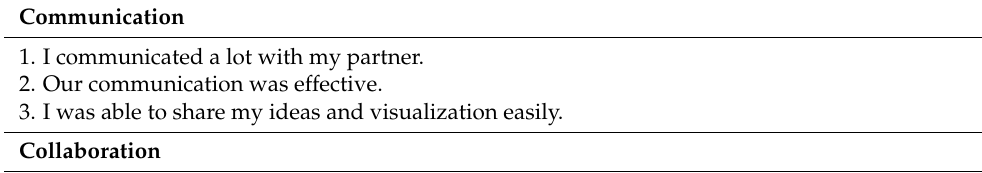
Table 5. Questions defined for communication, collaboration, satisfaction, and comfort.